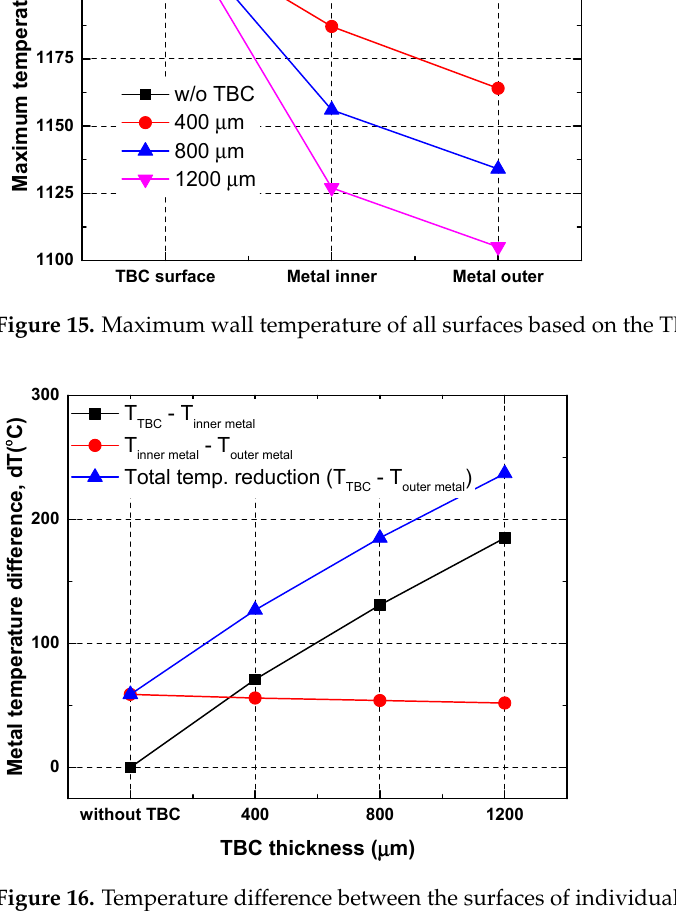
Figure 16. Temperature difference between the surfaces of individual TBC thickness cases.